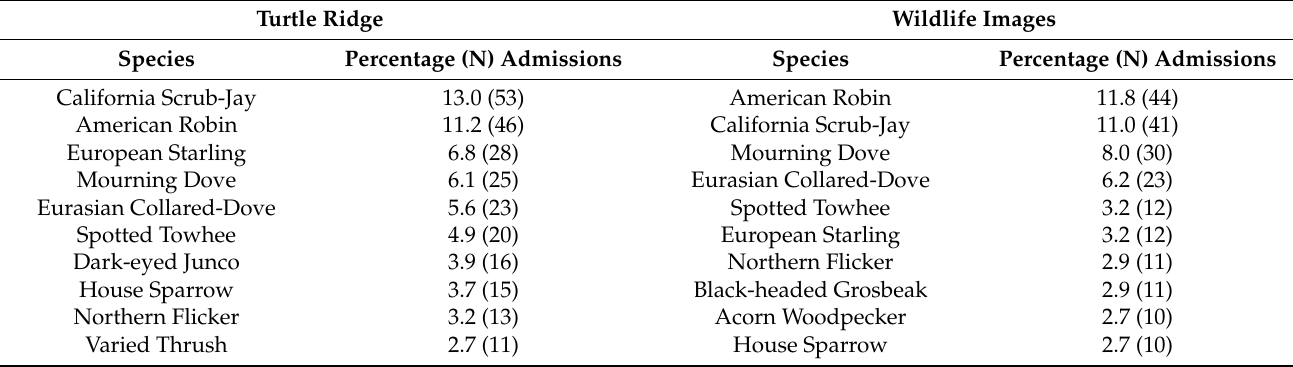
Table 4. Top ten species at each center admitted after interacting with a cat. One species (American Crow) with an adult body mass > 200 g was excluded. Percentages are calculated from all cat-related admissions at each center. Turtle Ridge